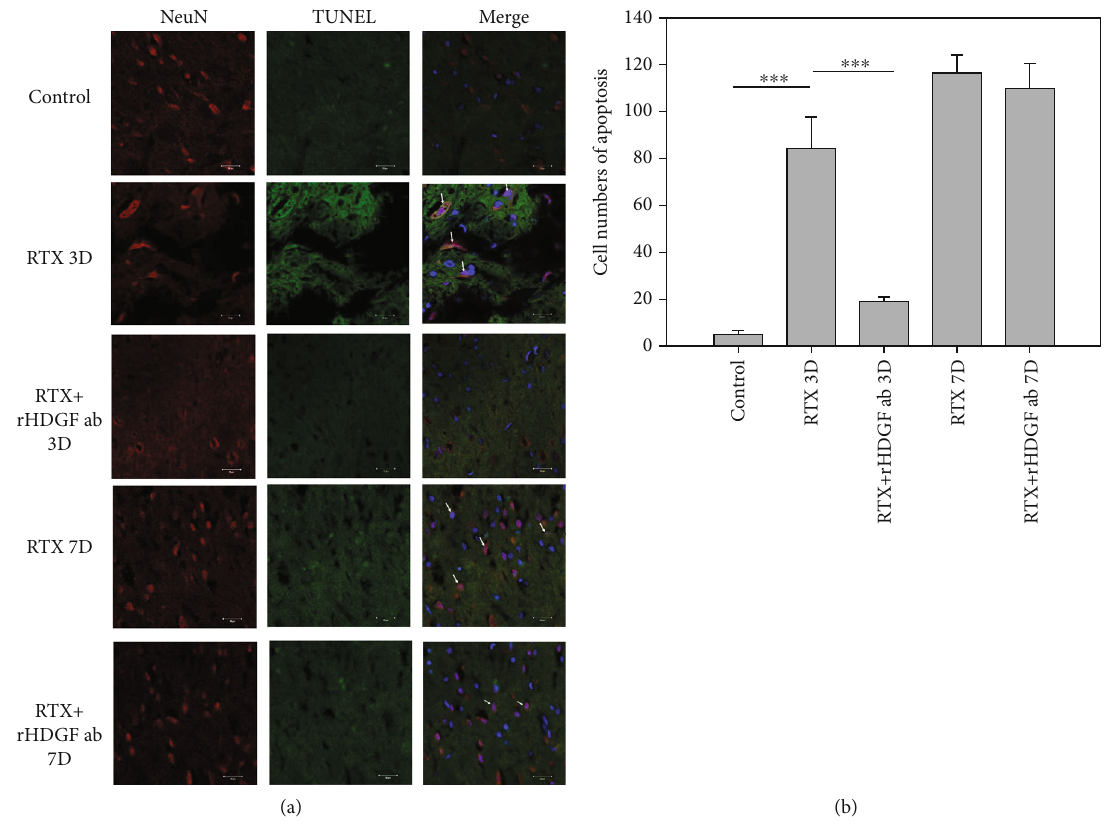
Figure 4: E ff ect of rHDGF antibody on neuron cells in the L3/L5 spinal cord dorsal horn of RTX-treated rats. After the rats were divided into three groups, neuropathy was induced by intraperitoneally administration of a single dose of RTX (50 μ g/kg). In the RTX+rHDGF antibody group, 100 μ g/kg rHDGF antibody was administered and applied 24 hours before RTX injection. The control group received no rHDGF antibody pretreatment and no RTX injection. At 3 or 7 days after RTX injection and/or pretreated with rHDGF antibody, L3-L5 spinal cord dorsal horn were harvested, and the expression of apoptotic neurons were evaluated through immuno fl uorescence staining by TUNEL assay (green), neuron cell marker (Neu-N) (Red), and DAPI (blue) (400x magni fi cation). (a) Representative immuno fl uorescence staining image shown are from 3 to 5 sections stained at least from 6 rats for each group. Apoptotic neurons visualized (indicated by arrows) in the dorsal horn of the L3/L5 spinal cord are also shown. (b) The numbers of apoptotic neurons per animal were shown. ∗∗∗ P < 0 : 001 . Data are expressed as the mean + SEM ( n = 6 per